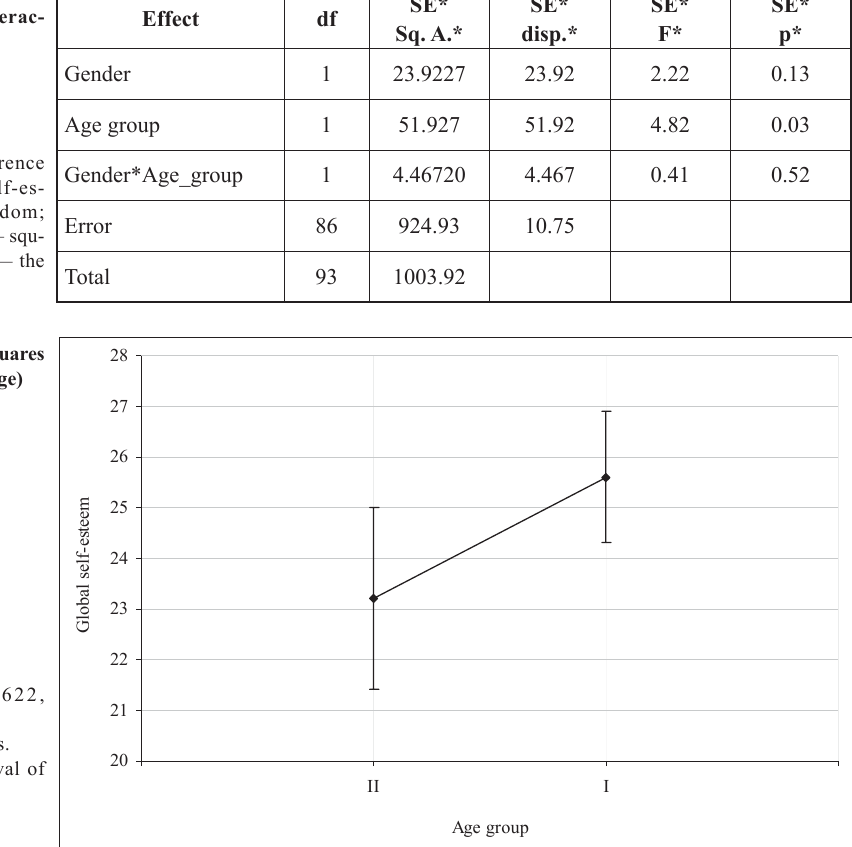
Table 1. MANOVA result — domain GLOBAL SELF-ESTEEM and interac- tion between the variables